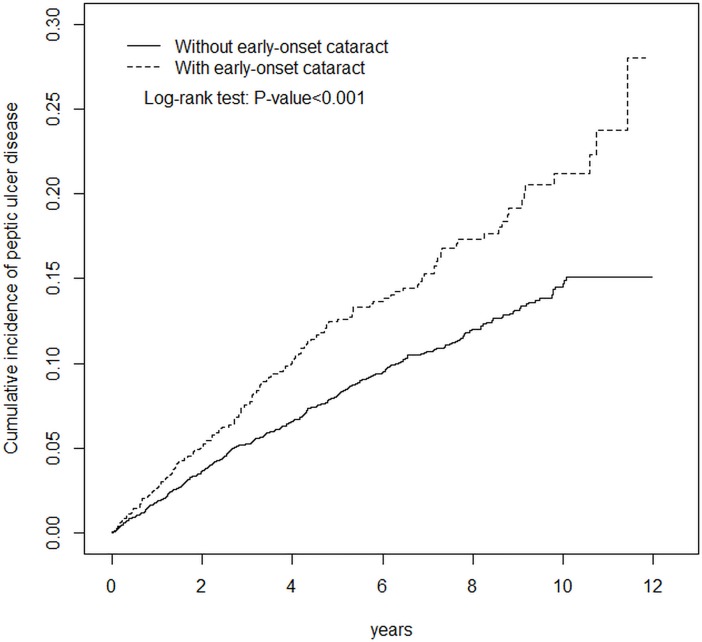
Cummulative incidence of peptic ulcer compared between patients with and without EOC.Patients with EOC had a higher cumulative incidence of peptic ulcer than those without EOC.